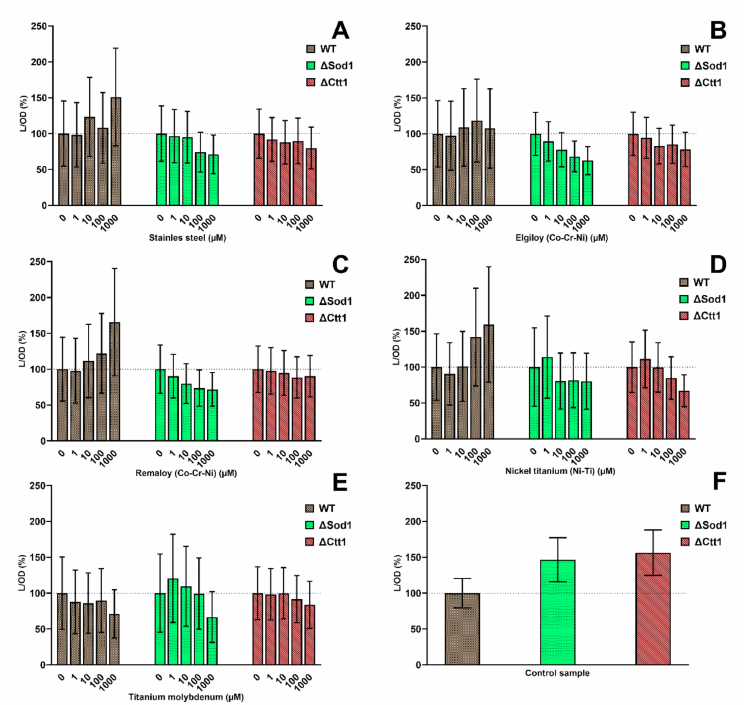
Figure 2. Metabolic activity of wild-type yeast and two yeast mutants ∆ Sod1 and ∆ Ctt1 treated with di ff erent combinations of metal ions: stainless steel ( A ), cobalt-chromium Elgiloy ( B ), Remaloy ( C ), nickel-titanium ( D ), and β -titanium ( E ). For each yeast strain, the untreated control group represents 100% (dotted line). A comparison among untreated control groups of each yeast strain is shown in the graph ( F